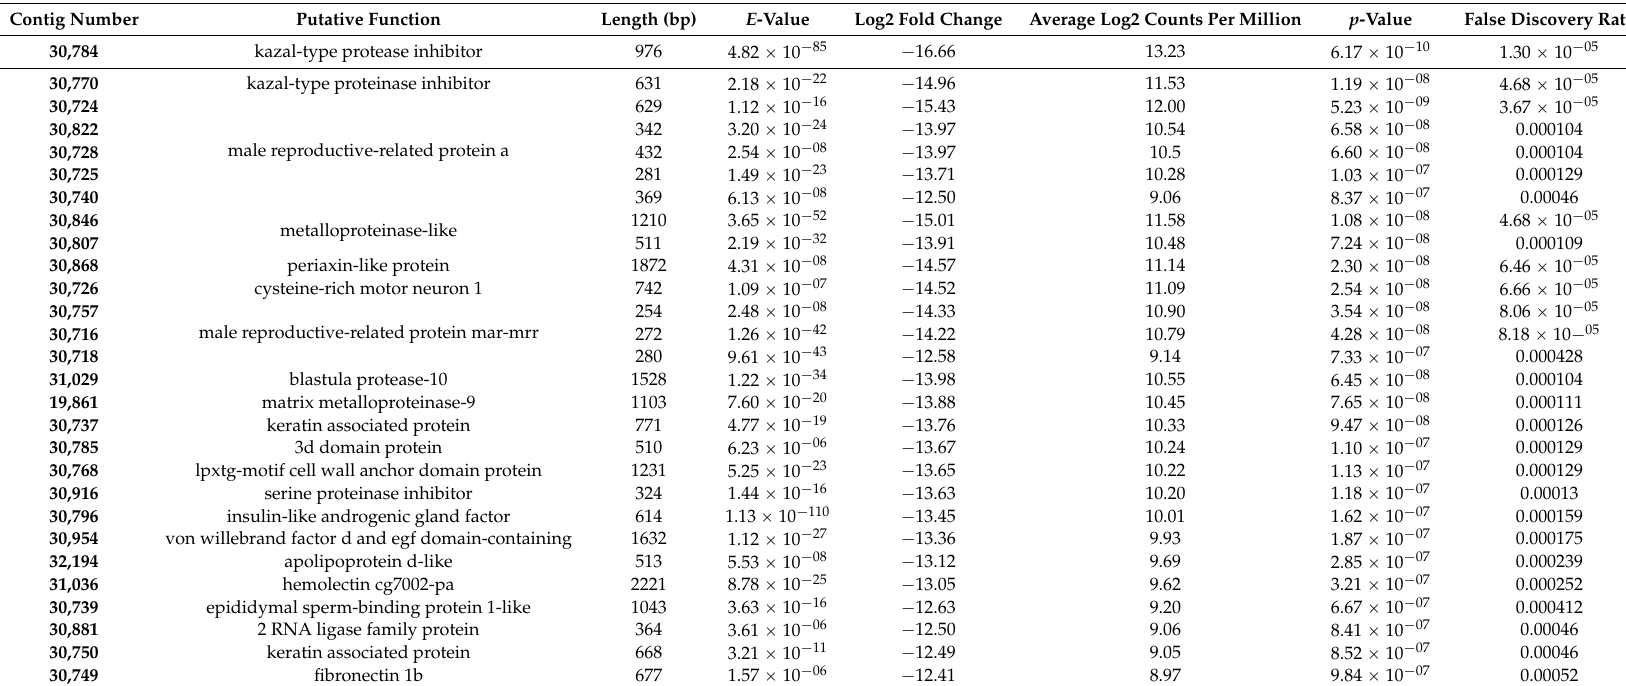
Table 3. Top 20 differently expressed genes from ovary and testis tissues in M . rosenbergii . Minimum E -value (<10 ´ 5 ) and exclude hypothetical/predicted proteins. Contig